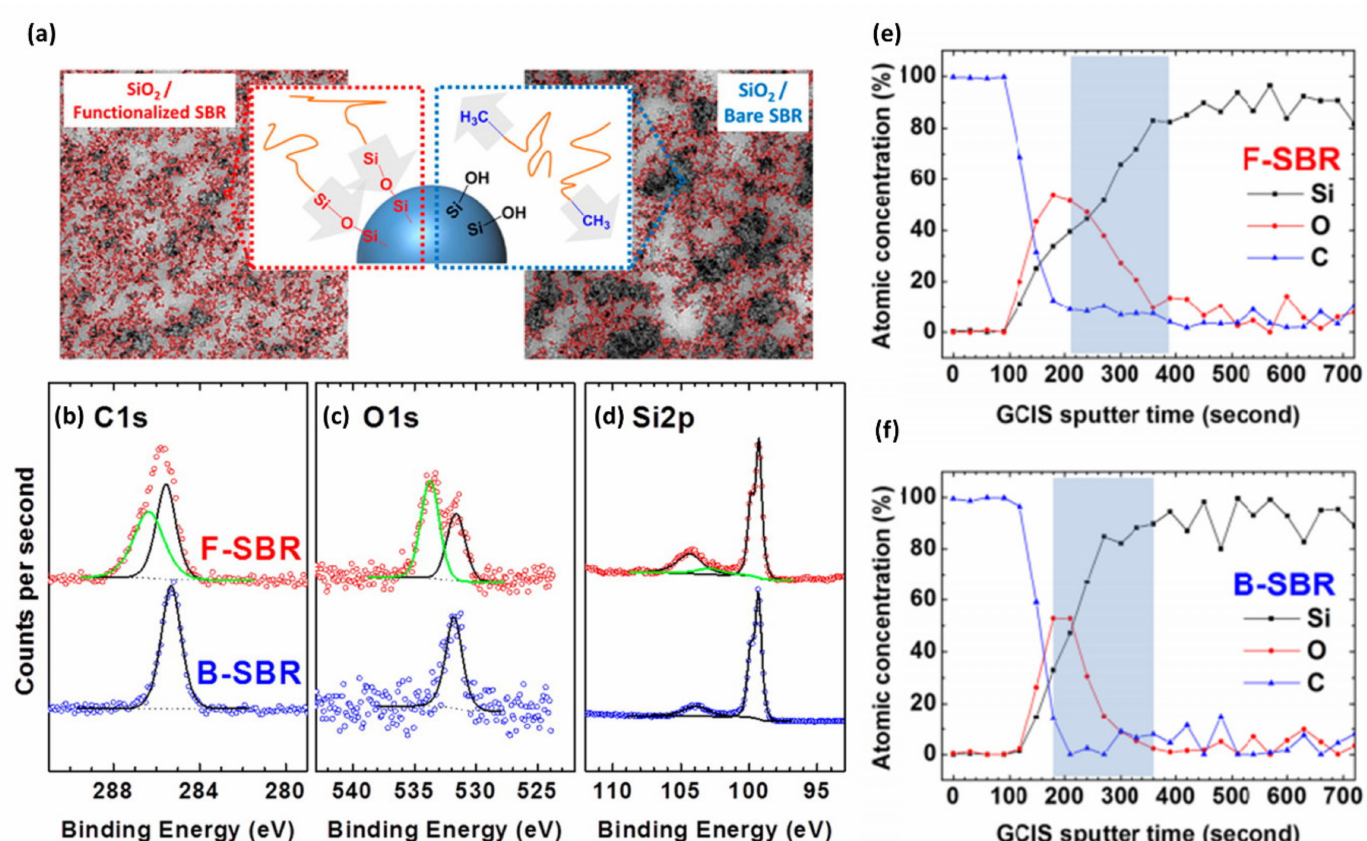
Figure 10. ( a ) TEM images, ( b – d ) XPS multiplex spectra, and ( e – f ) depth profiling results of the SiO 2 / functionalized styrene-butadiene (SBR) polymer (F-SBR, red) and SiO 2 / bare SBR (B-SBR, blue) nanocomposites. (Reproduced with permission from Reference [42]; Copyright (2015) American Chemical